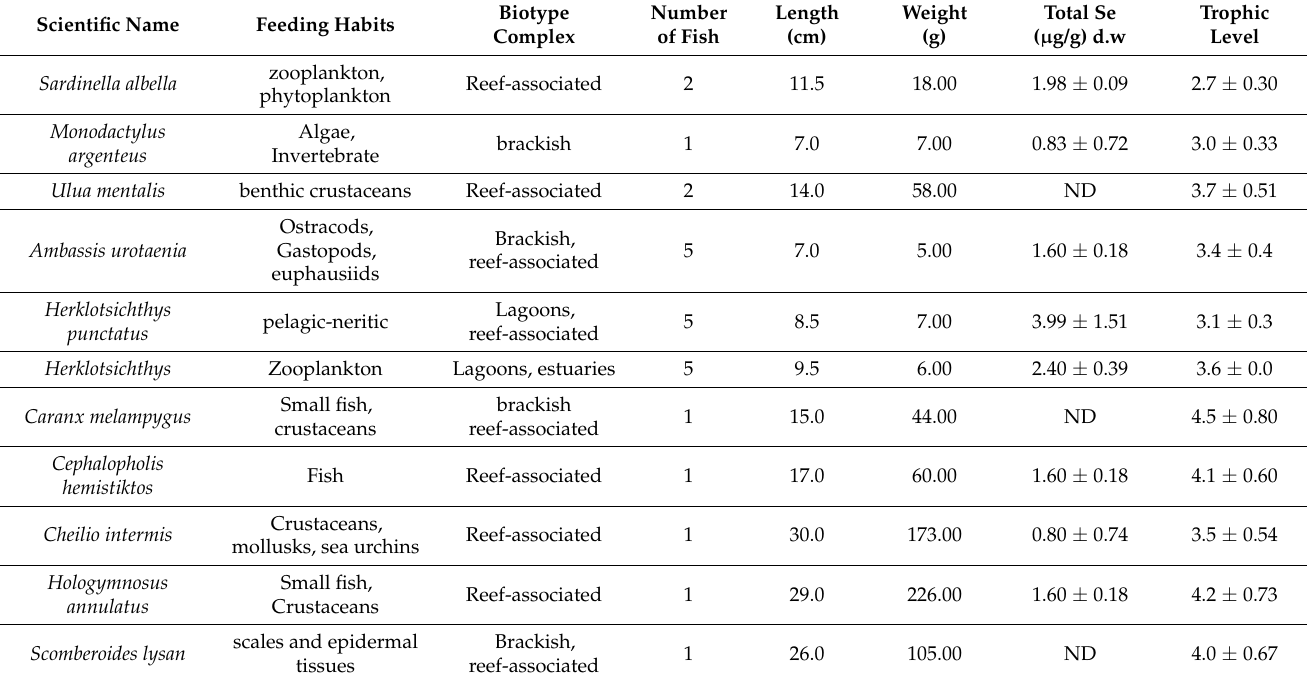
Table 4. Fish species’ biological, physical, and chemical properties, collected from www.fishbase.com (accessed on 10 Jan